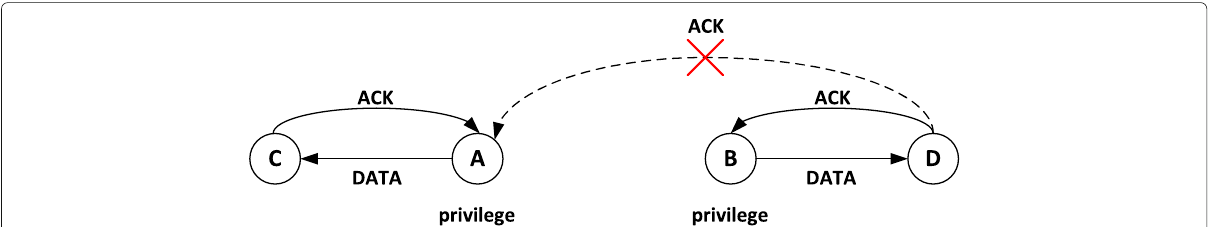
Fig. 6 A scenario where two nodes possess privilege and cause packet collisions. When node B receives an ACK from node D, node A should release